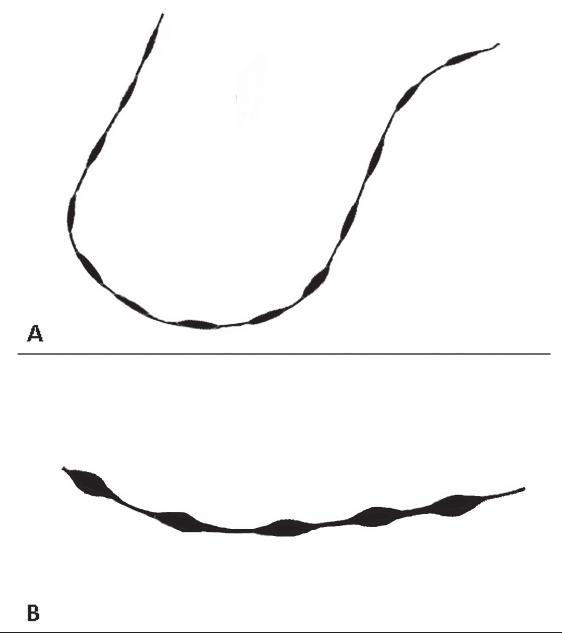
figurE 3 − Illustration showing the pattern and characteristics of the hair under light microscopy. Note the beaded appearance of the hair (A and B) due to the spindle-shaped nodes of normal thickness regularly interspersed with areas of